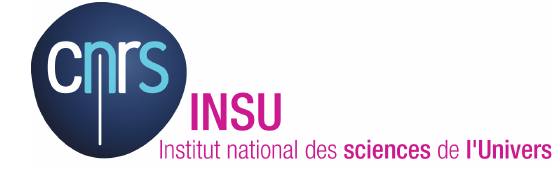
Fig. 10. Piezometric and production reservoir level variations for Figure 10: Variations in piezometric and production store contents in September 2002 and 10 September 2002 and December December 2003 11